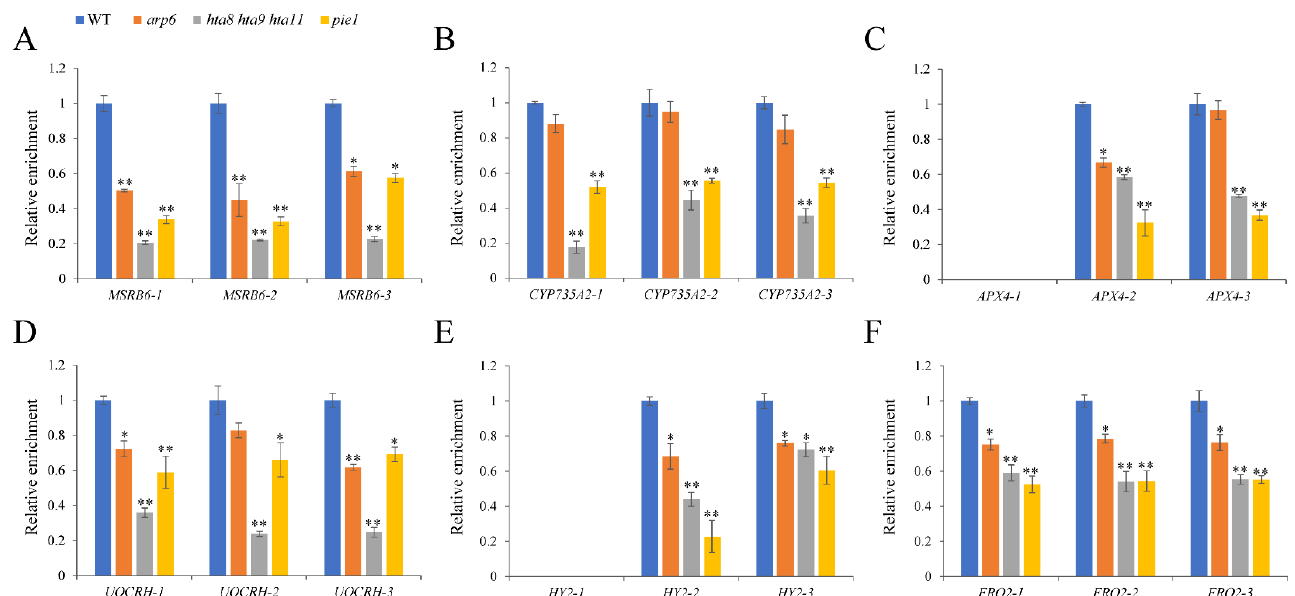
Figure 7. H3K4me3 enrichment in oxidoreductase activity-related genes was altered in arp6 , hta8 hta9 hta11 , and pie1 roots: ( A – F ) ChIP-qPCR analysis of the H3K4me3 enrichment in MSRB6 , CYP735A2 , APX4 , UQCRH , HY2 , and FRO2 genes in WT, arp6 , hta8 hta9 hta11 , and pie1 roots. Primer set numbers are the same as those listed in Figure 5. Error bars indicate ± SD ( n = 3 replicates). Asterisks above the columns indicate statistically significant differences (* p < 0.05, ** p < 0.01) determined by Student’s t test.